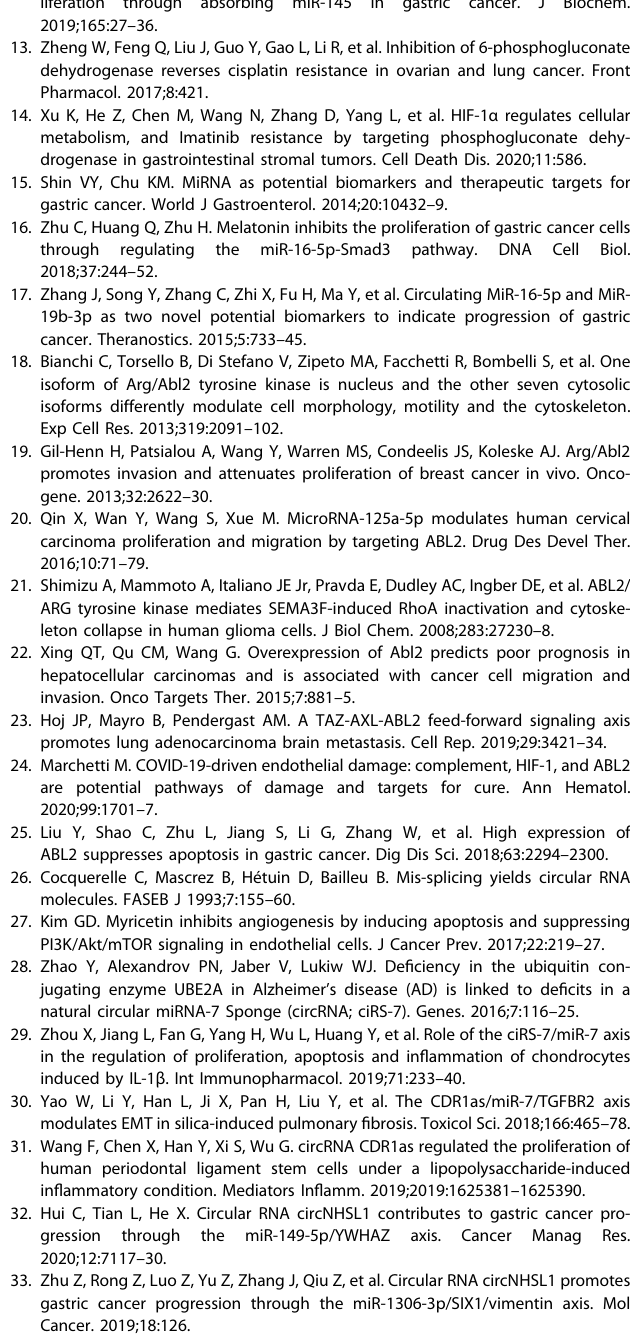
Fig. 8 CircPGD encodes a novel PGD-219aa protein and promotes GC cell growth and migration while suppressing their apoptosis. A Prediction of open reading frame (ORF) containing the reversed spliced sites in circPGD. B Western blotting detected whether circPGD-Flag plasmids expressed Flag proteins in 293T cells. C Protein puri fi cation in MGC-803 cells subject to transfection with circPGD-219aa-Flag and Co- IP using Flag antibody, followed by validation through western blotting. LC – MS/MS was applied for identifying peptide sequences of collected proteins. The front (upper right) and the end (lower right) amino acid sequences are displayed. D – H The function of PGD-219aa-Flag plasmids in GC cells was monitored. D Transwell migration, E colony-formation, F CCK-8, G wound healing and H apoptosis assays result compared with the control vector in GC cells. I Sample maps of circPGD-219aa plasmids. J Western blotting detected PGD-219aa expression in GC cell lines transfected with vector, circPGD-219aa-Flag, cricPGD-219aa-mut-Flag, and PGD-219aa plasmids using the Flag antibody. K Wound healing, L CCK-8, M colony-formation, N Transwell migration, and O apoptosis assays analyzed the effects of empty vector, as well as circPGD-219aa- Flag, cricPGD-219aa-mut-Flag and PGD-219aa plasmids on GC cell migration, proliferation, and apoptosis. P, Q , and R Western blotting detected whether PGD-219aa affected EMT, as well as apoptosis- and signaling pathway-related